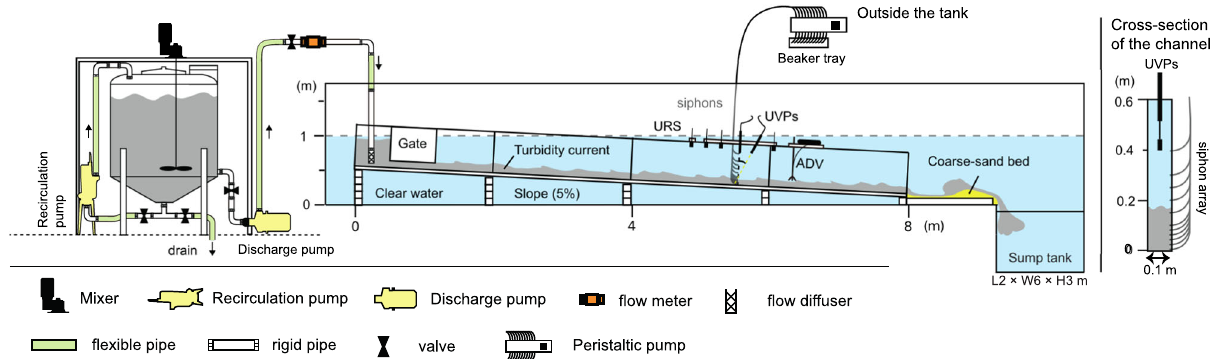
Fig.7|Schematicillustrationoftheexperimental fl ume. The fl owsamplinglocationisat4.7mfromtheinlet(5.7mdownstreamfromtheupstreamendofthechannel). The cross-section of the channel at the measurement location is depicted on the right side of the fi gure.